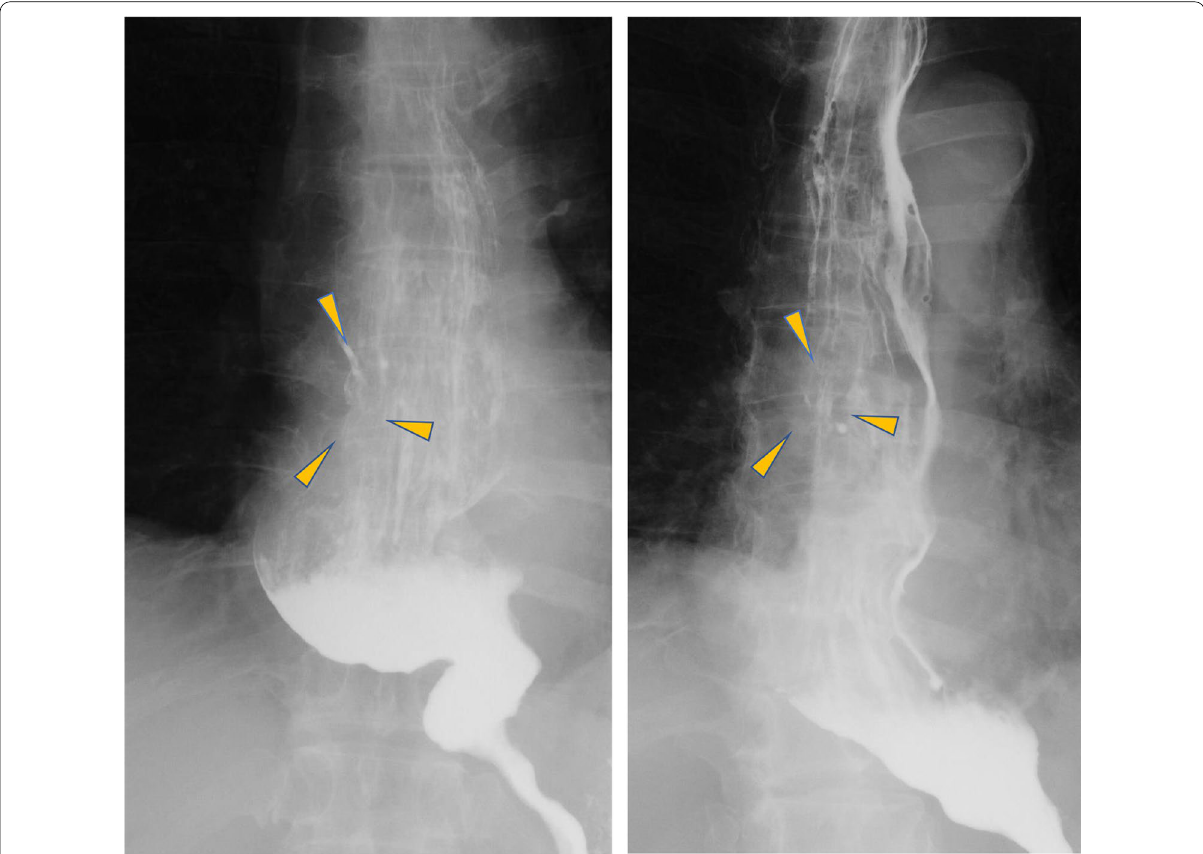
Fig. 4 Preoperative fluoroscopy with gastrografin (arrow head, tumor). Although the esophagus on the anal side from Mt to the EGJ was dilated, passage of gastrografin is